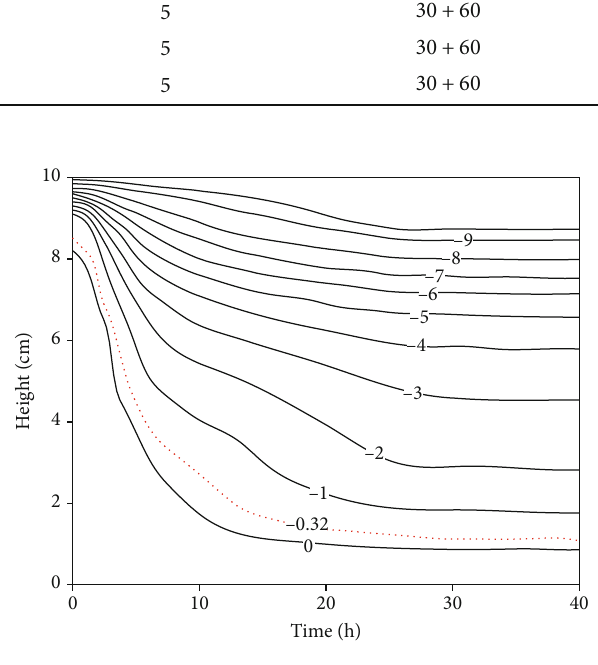
Figure 6: Temperature change process of SS.